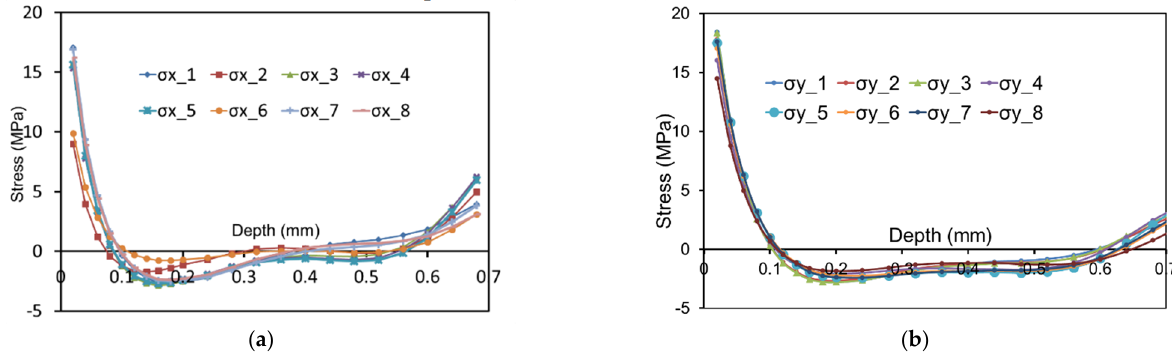
Figure 14. Residual stress values determined by the hole drilling method (HDM) at center point A (shown in Figure 7b) with respect to ( a ) σ x and ( b ) σ y .